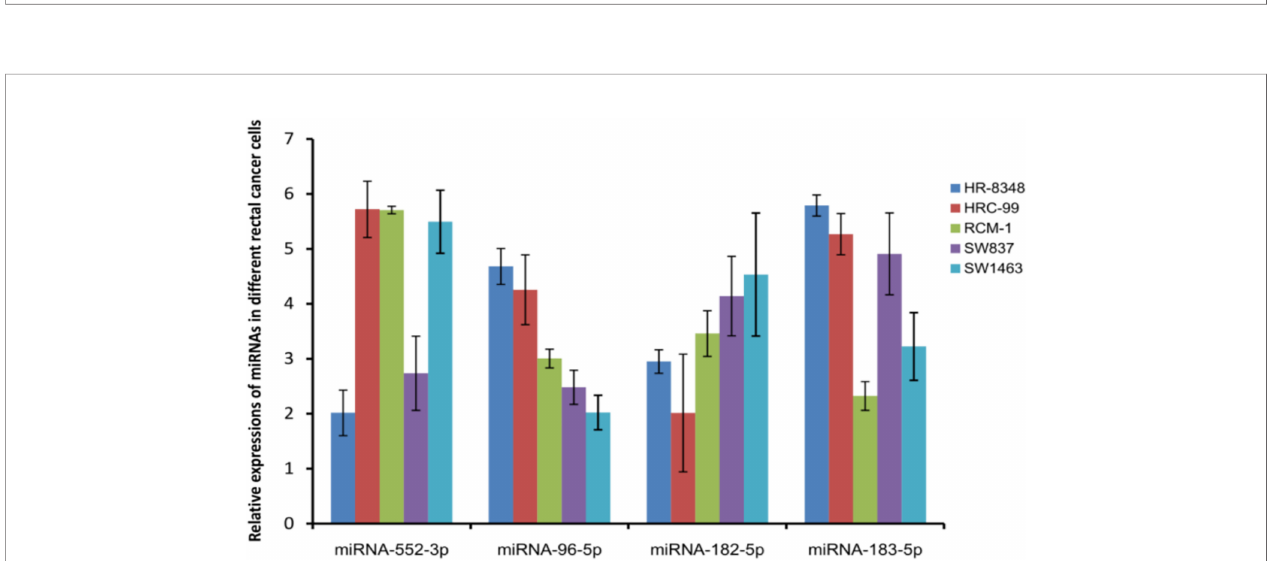
FIGURE 4 | Detecting the expression of miRNAs positively correlated with irradiation resistance in rectal cancer cell lines showed that the expression of miRNA-96- 5p was positively correlated with the radiation resistance of the